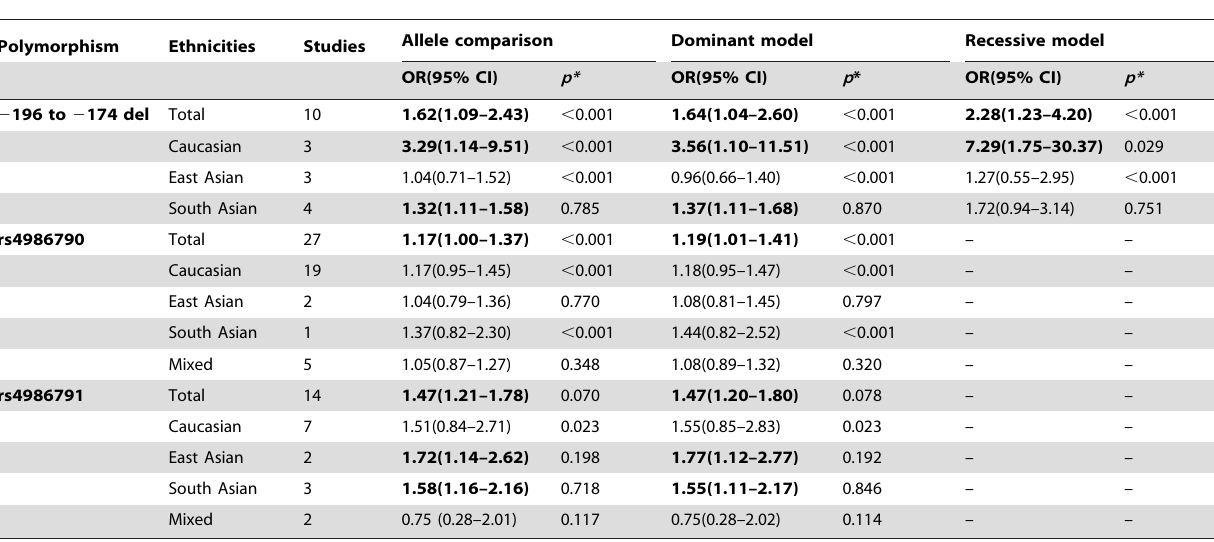
Table 2. Associations between TLRs polymorphisms and overall cancer risk by